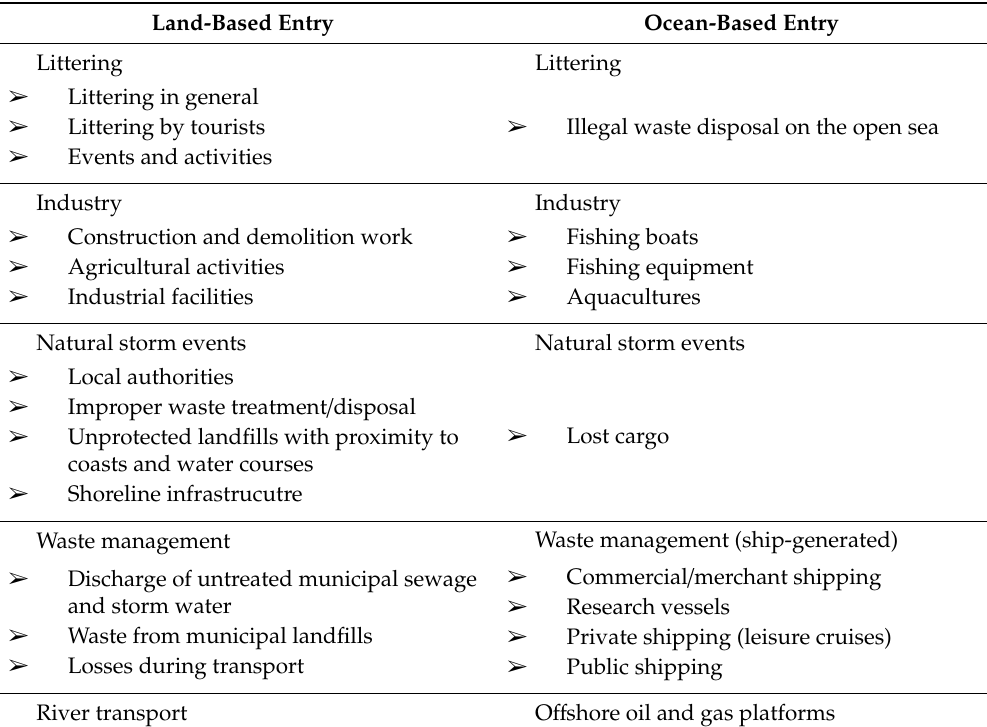
Table 1. Entry paths of macroplastic (based on based on